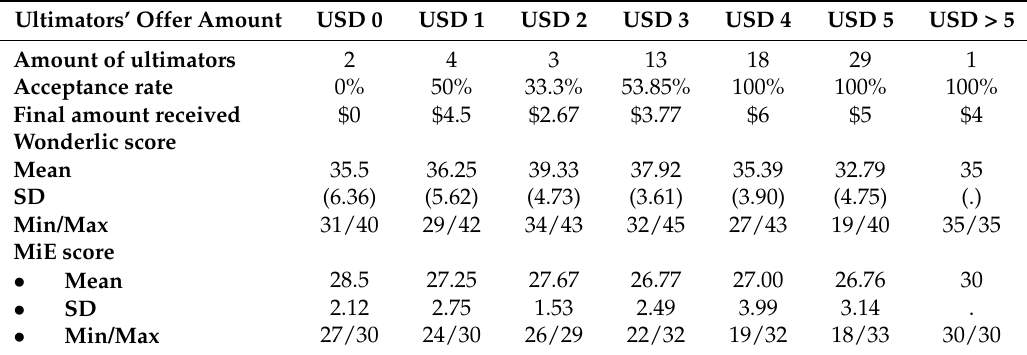
Table 4. Ultimator’s offer, Wonderlic scores, and MiE scores.